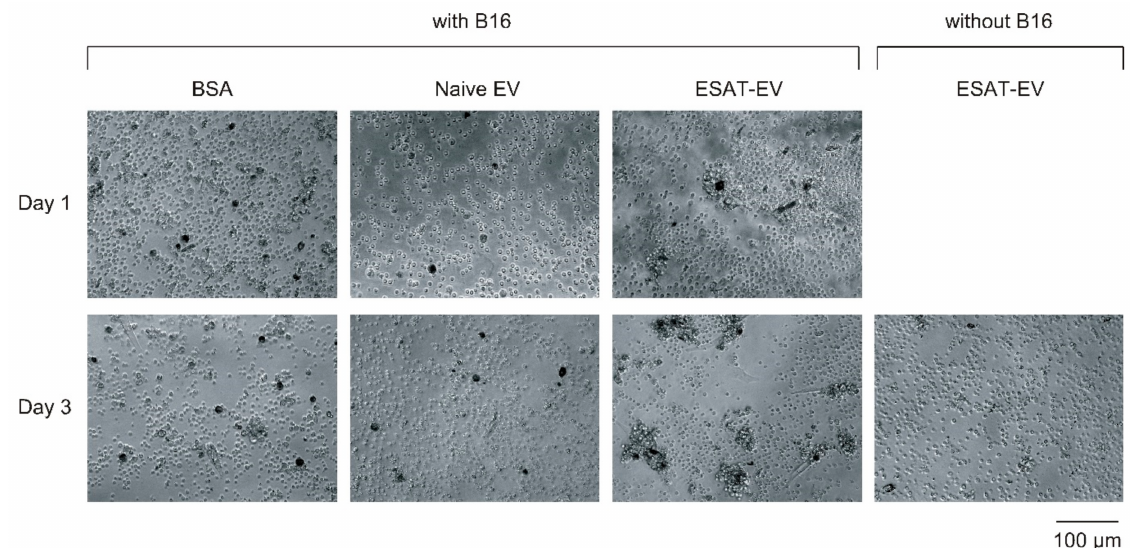
Figure 6. Microscopic images of leukocytes from EV-treated mice incubated with B16 cells. Suspension of ESAT-EV, Naive EV, or BSA solution was injected twice into mouse foot pads on Days 0 and 10. On Day 20, the cells in popliteal lymph nodes were collected, and co-cultured with EV-parent B16 cells pretreated with Mitomycin C at the cell number ratio of leukocyte/B16 = 20:1. Images were taken after 1 or 3 days of co-culture.